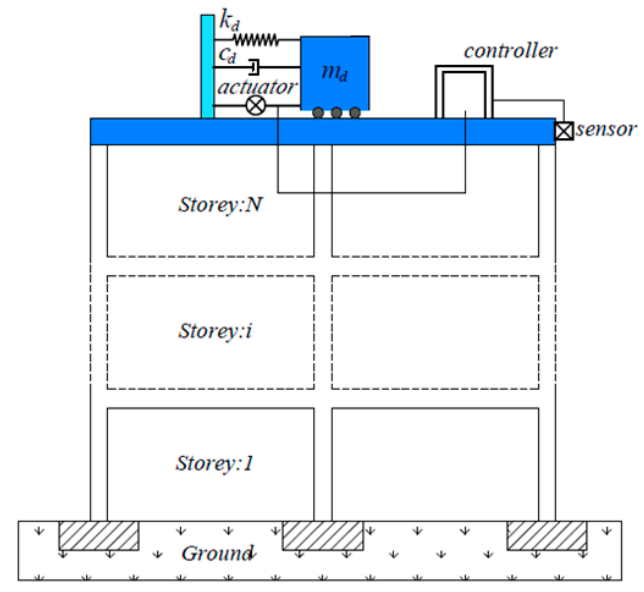
Figure 1. General component of structure with an active tuned mass dampers (ATMD) system.